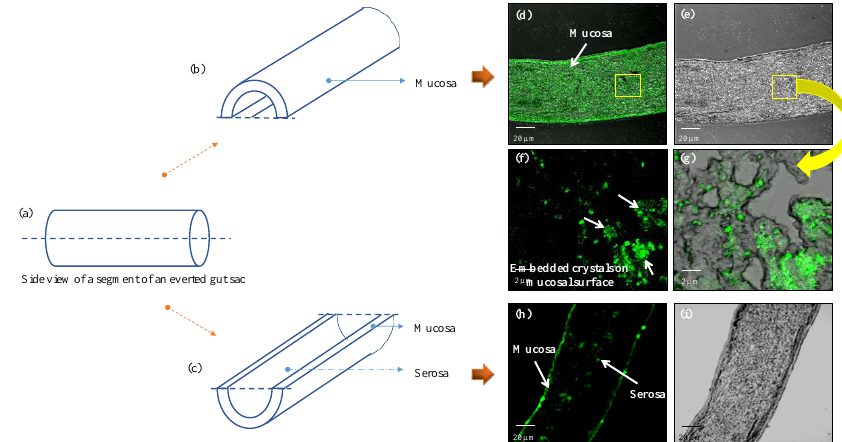
Figure 7. Schematic representation of the mucosal and serosal side on everted gut sac: ( a ) Side view of the jejunum segment of the everted gut sac; ( b , c ) depict the mucosal and serosal side of the gut sac after sectioning (longitudinal). CLSM images ( d – i ) of NSD treated gut represent: ( d ) phase contrast and ( e ) bright field of the mucosal side. Images ( f , g ) represent a zoomed in picture of the images ( d , e ) which show the presence of crystals embedded on the mucosal surface. Images ( h , i ) represent the phase contrast and bright field of the serosal side of the gut.